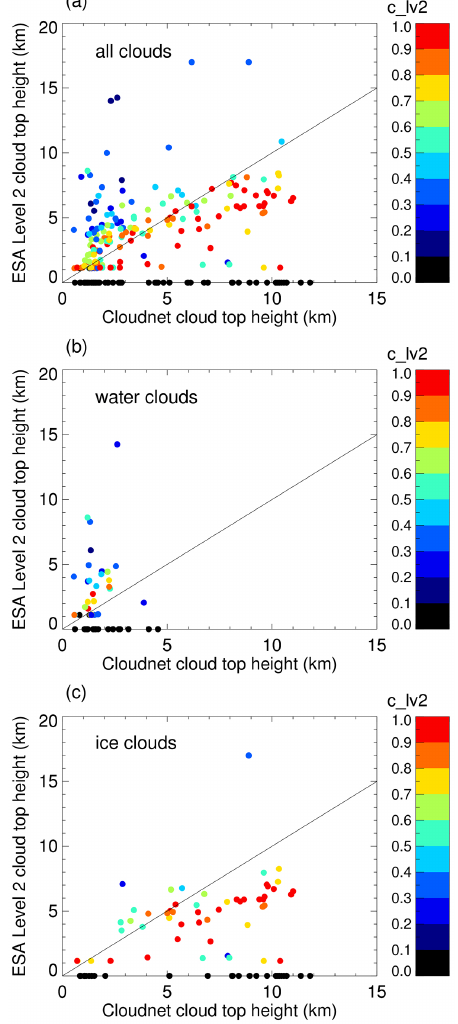
Figure 6. Scatter plots of SCIAMACHY ESA L2 cloud top height versus Cloudnet cloud top height for (a) all single-layer clouds, (b) single-layer water clouds, and (c) single-layer ice clouds. The color of the symbol indicates the ESA L2 cloud fraction, with the color code given by the vertical bar. The black line is the one-to-one line. For the points with c_lv2 > 0.1, the correlation coefficients are (a) 0.451, (b) 0.247, and (c) 0.426.